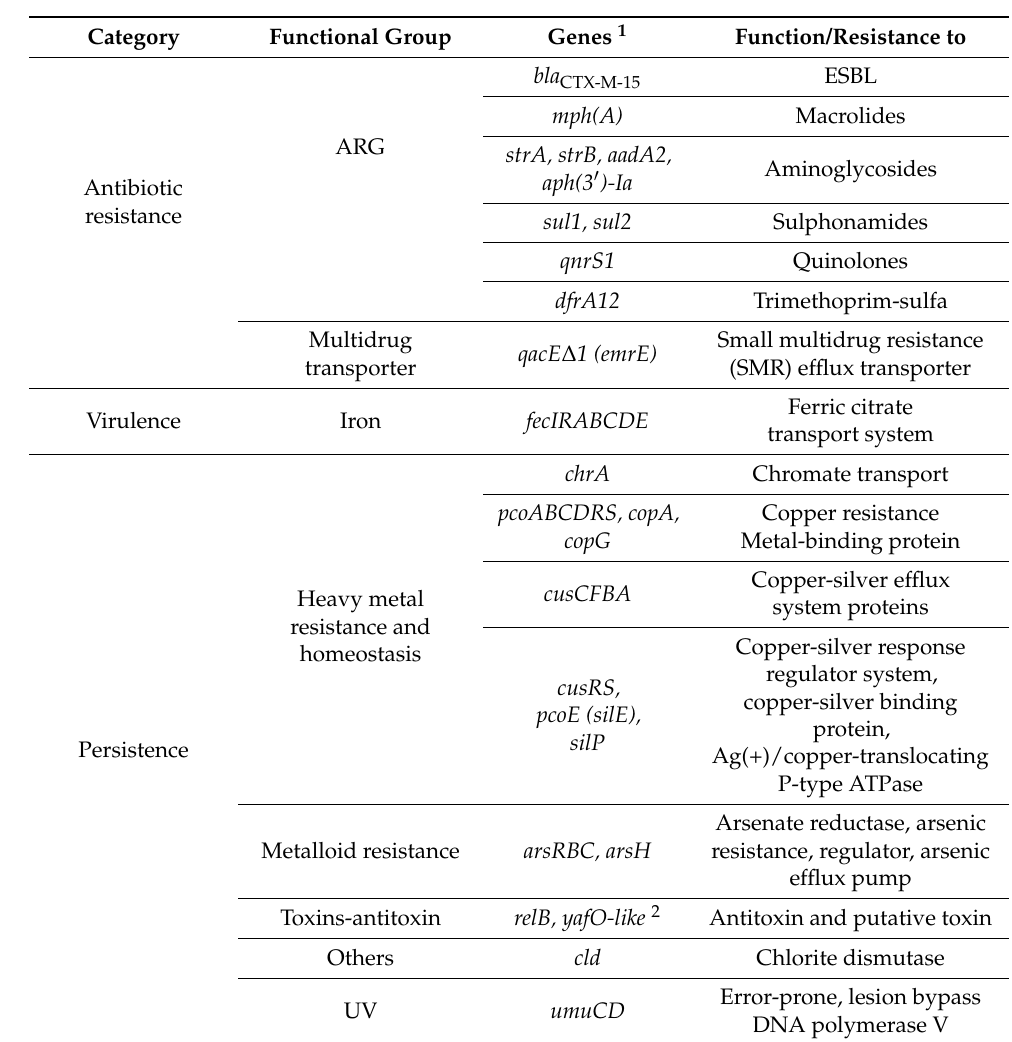
Table 3. Accessory genes encoded on